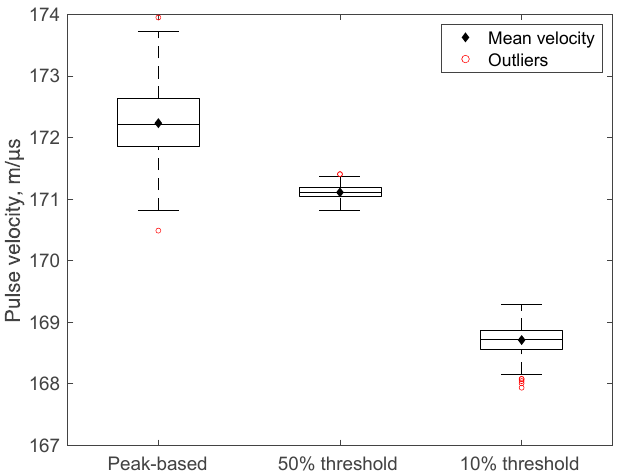
Figure 10. Pulse velocity box plots for 1 nC pulse injected at the far end of the cable, measured using the IEC 60270-compliant system.